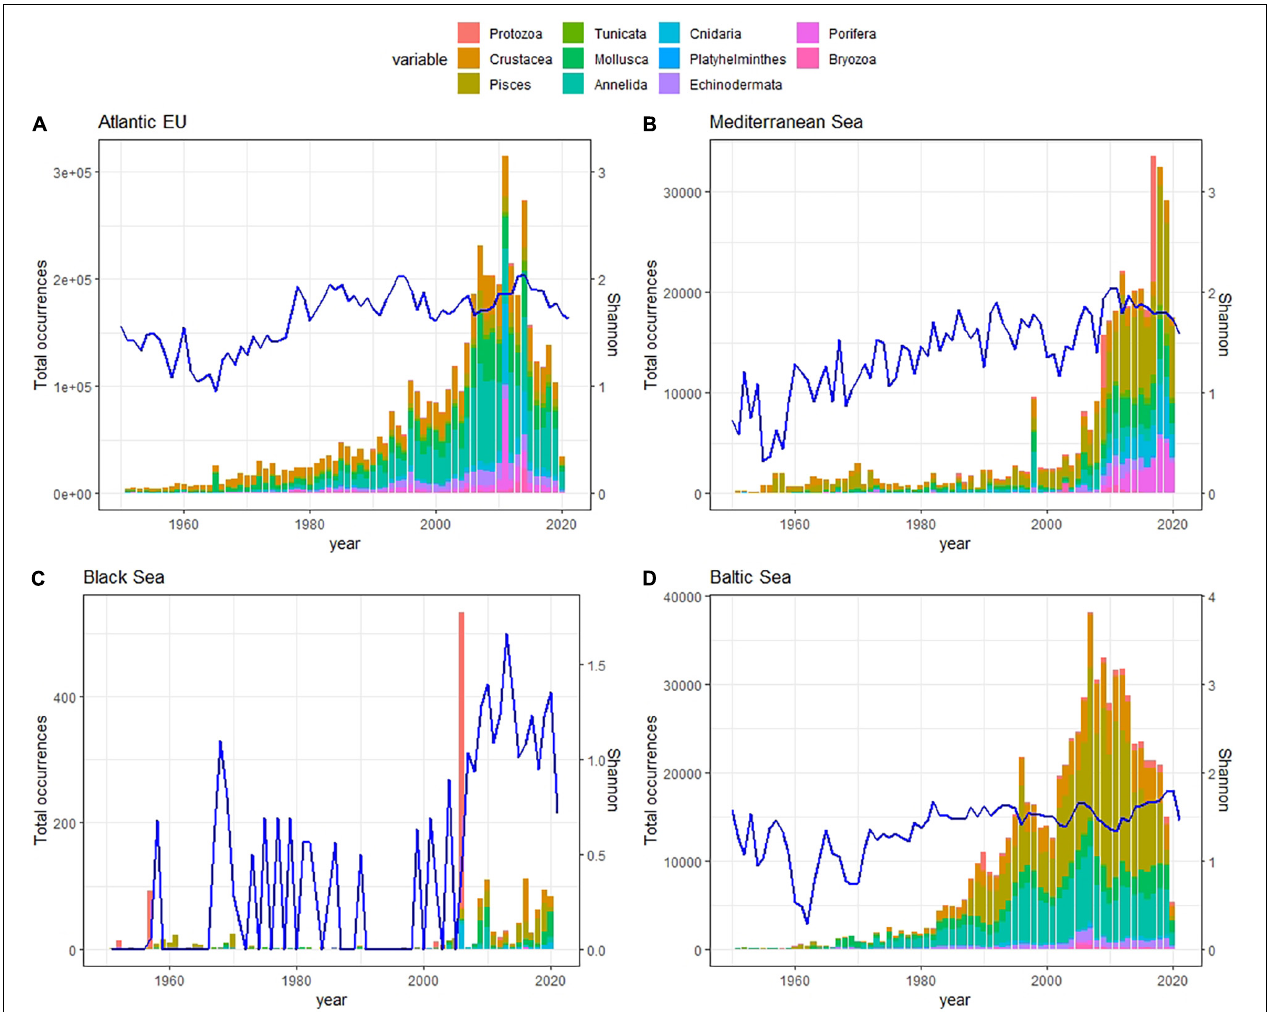
FIGURE 4 | Stacked bar plot showing basin-specific trends in the total number of occurrences per taxa along the last decades for the Atlantic EU (A) , Mediterranean Sea (B) , Black Sea (C) , and Baltic Sea (D) . Note that first occurrences date back to the XVII century, but here we just represent the 1950–2020 period. Different taxa are represented in colors, and the year-specific Shannon Index (blue line), which considered the relative contribution of particular taxa to the total number of occurrences reported for a given year and basin, was used as an indicator of the completeness in taxonomic sampling along the